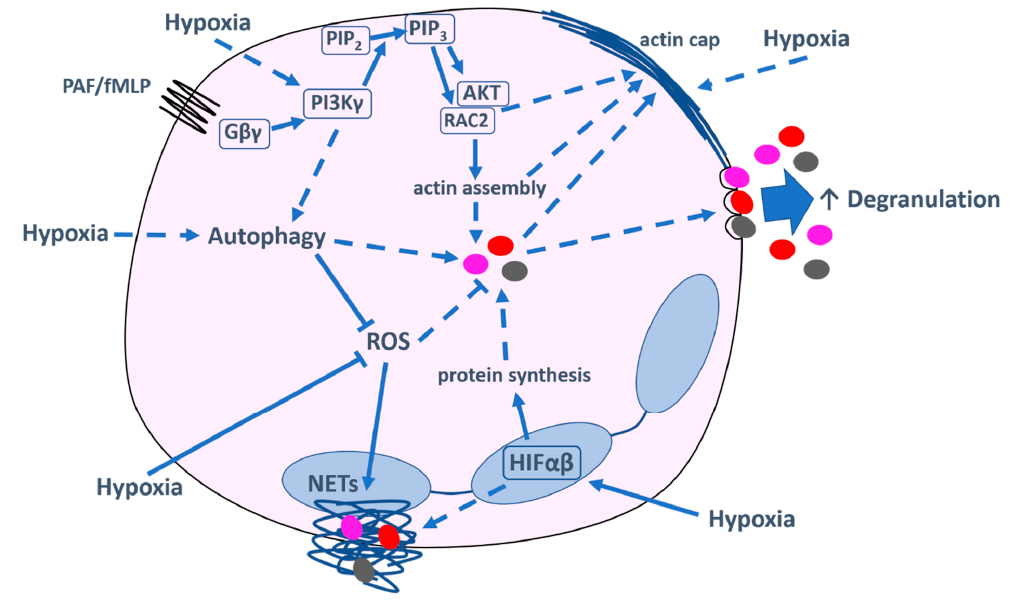
Figure 1. Mechanisms of hypoxia ‐ enhanced neutrophil degranulation. Hypoxia increases neutrophil degranulation in a phosphoinositide 3-kinase γ (PI3K γ )-dependent manner: activation of PI3K γ by degranulation in a phosphoinositide 3 ‐ kinase γ (PI3K γ ) ‐ dependent manner: activation of PI3K γ by